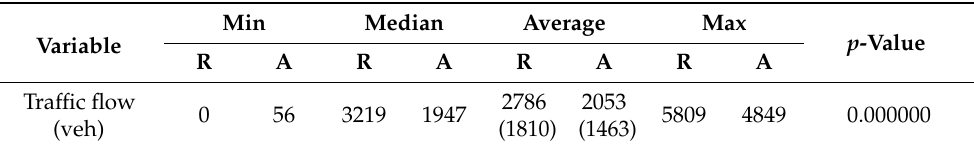
Table 1. Descriptive statistics for traffic flow during reference period R (10 March–30 May 2016–2019)